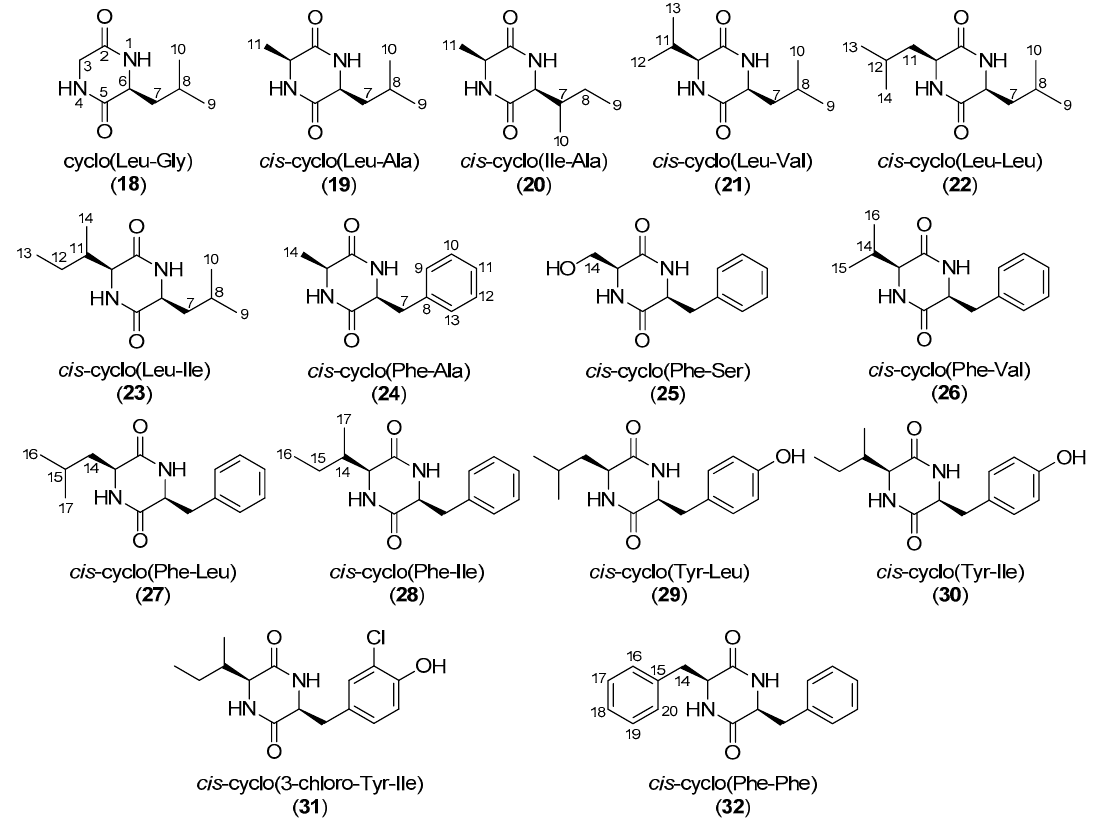
Figure 2. Chemical structures of compounds 18 – 32 isolated from various marine-derived bacterial